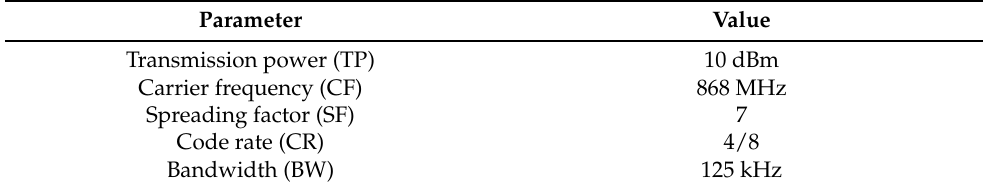
Table 1. Simulation parameters in the rural